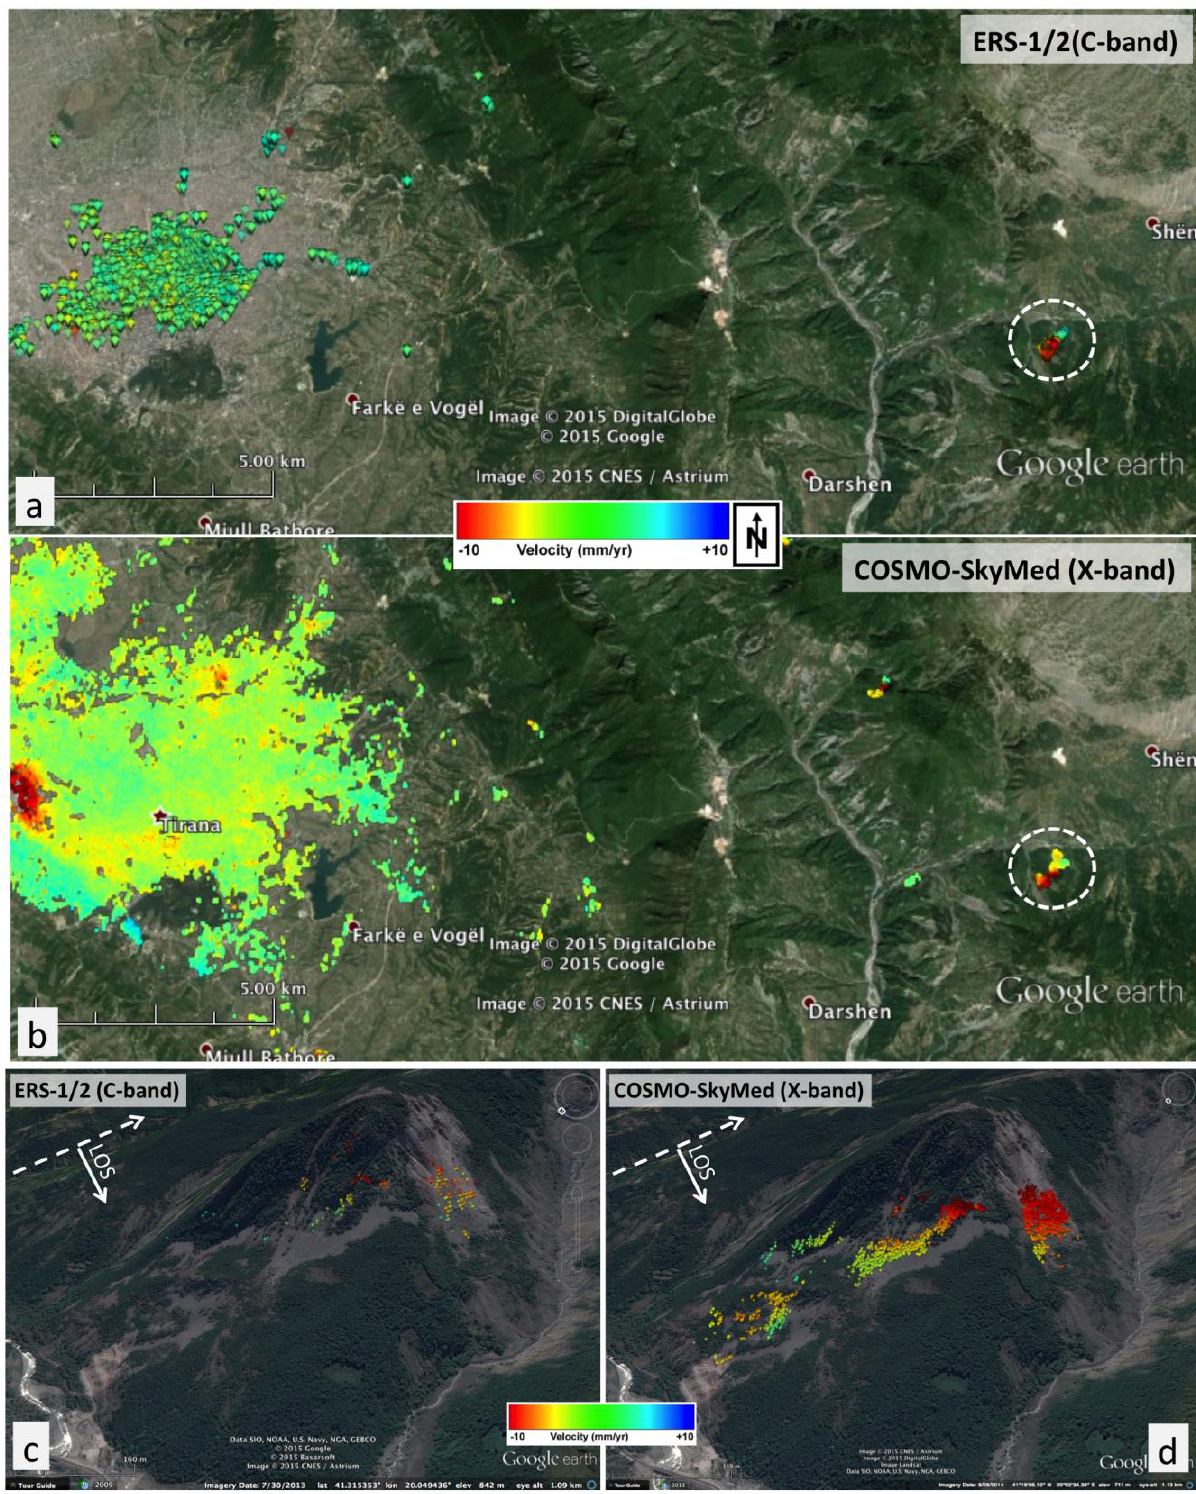
Figure 3. MTI results obtained from ERS and CSK data for the Central Albanian mountains. The distribution and average line of sight (LOS) velocity of radar targets are shown. Velocity values are saturated to ±10 mm/year. Yellowish-reddish and bluish dots represent radar targets moving, respectively, away from and toward the satellite sensor. (a) and (b) sub-regional scale overviews; (c) and (d) MTI results for a single hillslope (location marked by dashed circles in upper figures). Background from Google Earth